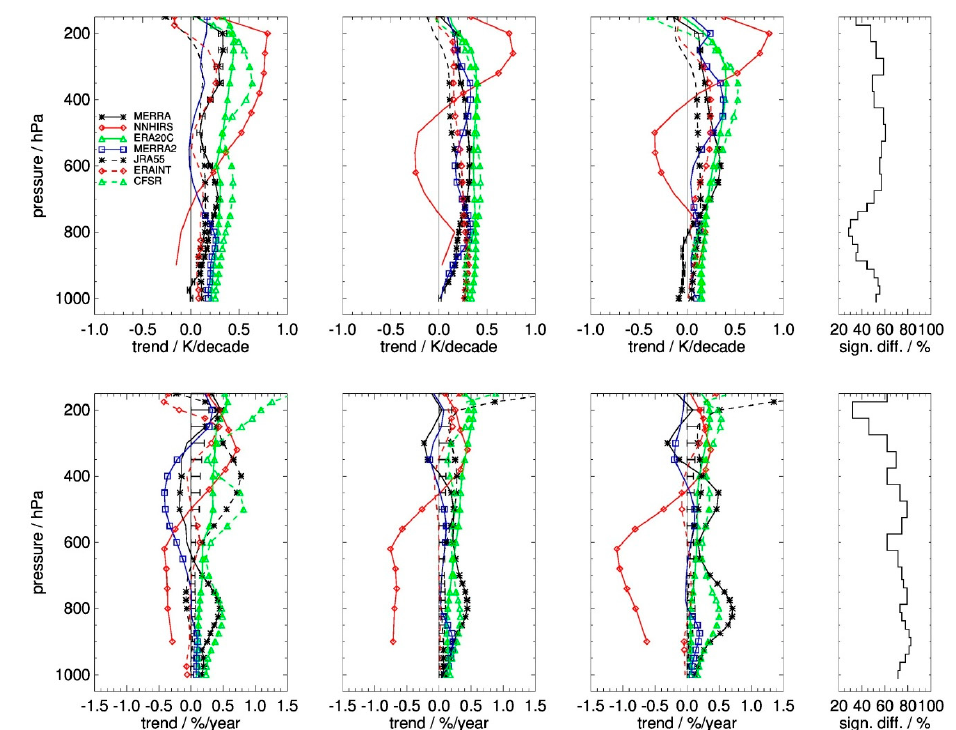
Figure 4. Trends in temperature ( top ) and specific humidity ( bottom ) as a function of pressure: left column —tropics (within 20°S - 20°N), second column —mid-latitudes of the northern hemisphere (within 20°N-60°N), third column —mid-latitudes of the southern hemisphere (within 20°S–60°S). Note that vertical profiles have not been interpolated onto a common vertical grid. Asterisks mark trend estimates which are significantly different from 0%/year or 0 K/decade. For MERRA the uncertainty estimate for the trend is also included. The right column shows the average percentage of data records being significantly different from one another. Note that the x-axis covers the range 20–100%. The results are based on seven data records that cover the period January 1988–December 2009.